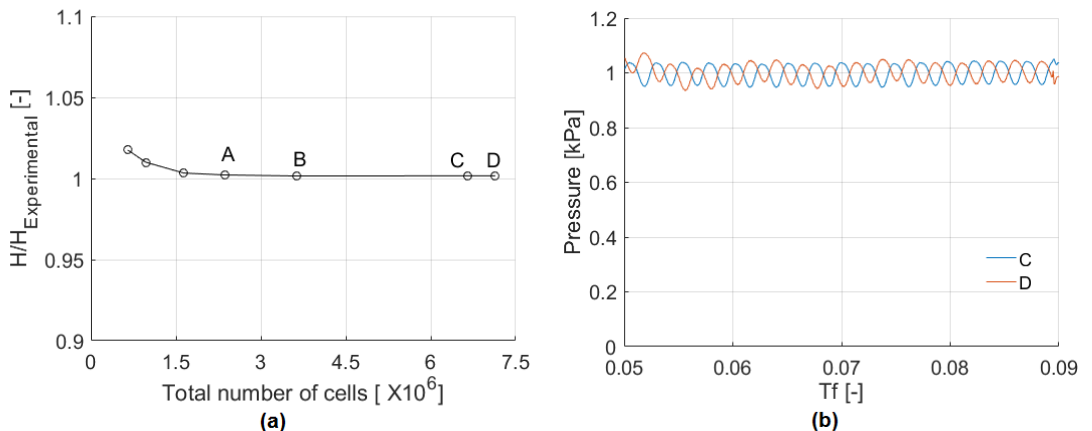
Figure 3. Sensitivity analysis of the mesh. ( a ) Solutions for different grid sizes; and ( b ) detail of pressure fluctuations at monitoring point R3 for grids C and D.